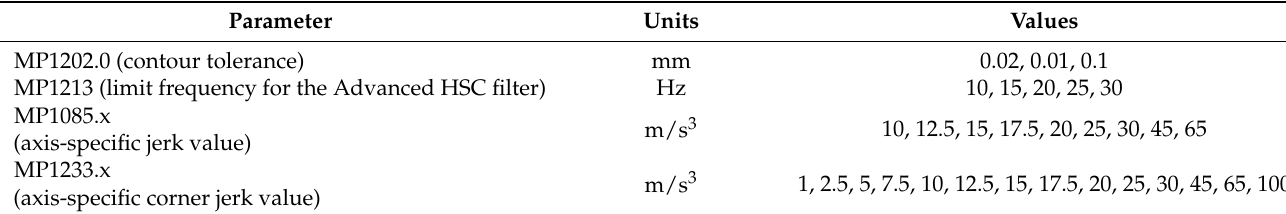
Table 1. Interpolator parameter values investigated in this